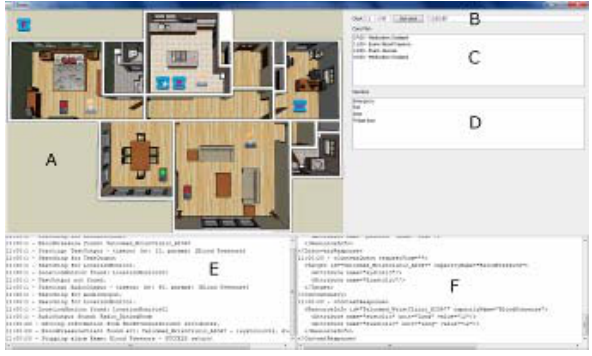
Figure 2. 3D Simulator for a remote assisted living application deployed in a smart home intelligent